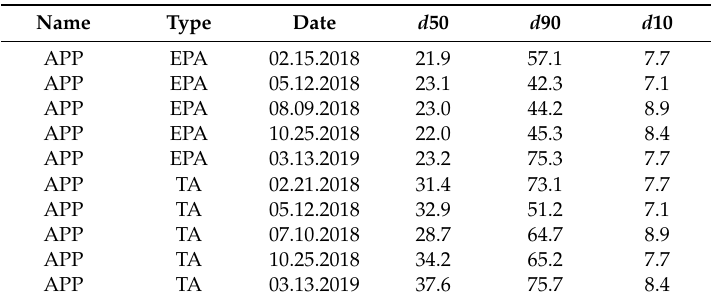
Table A2. Particle size distribution of APP ashes ( d 50, d 90, d